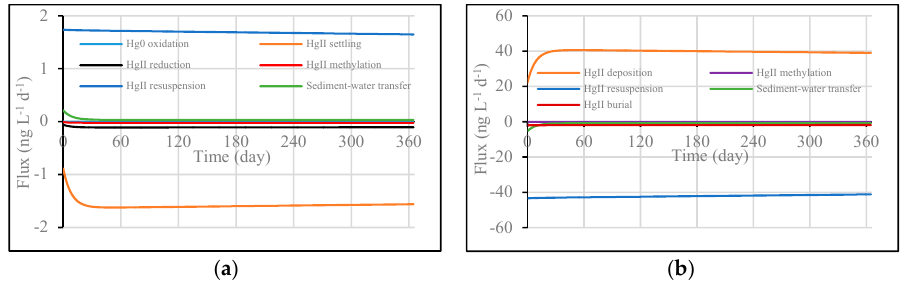
Figure 3. W2 and WASP computed HgII distributed concentrations in the water column ( a ) and the sediment layer ( b ): HgII (concentration of total HgII in water); HgII d (concentration of dissolved HgII in water); HgII pts (total concentration of solids adsorbed HgII in water); HgII 2 (concentration of total HgII in sediment); HgII d2 (concentration of dissolved HgII in sediment).